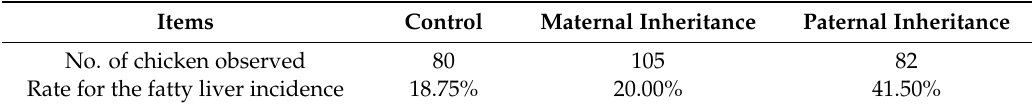
Table 5. The incidence of fatty liver in F1 generation of JXH